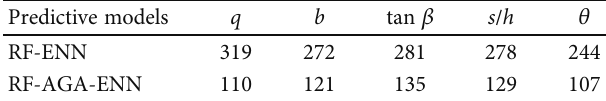
Table 9: The number of iterations of PIM parameters model solving. Predictive models